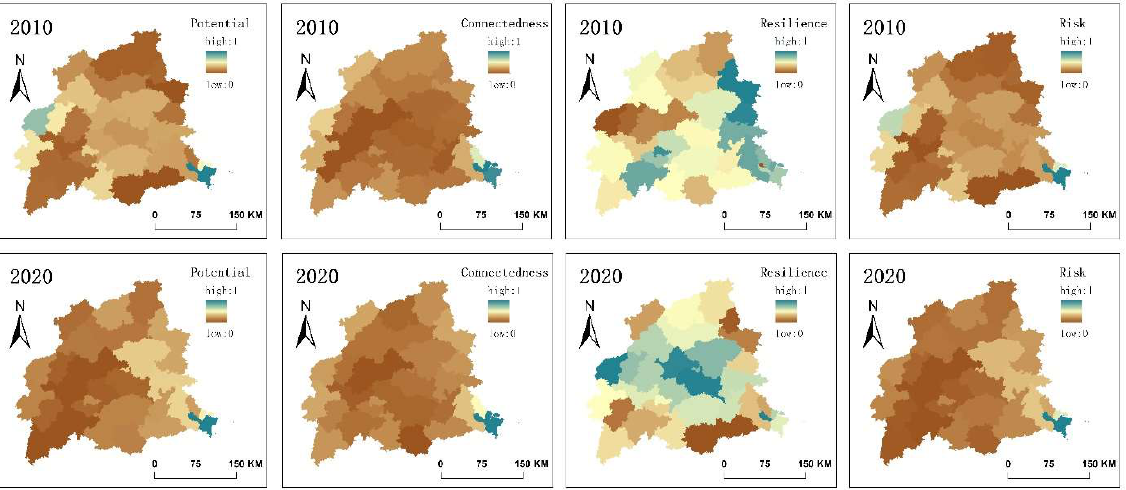
Figure 10. Spatial distribution of adaptive ecological risk values in counties and districts of Minjiang River Basin.